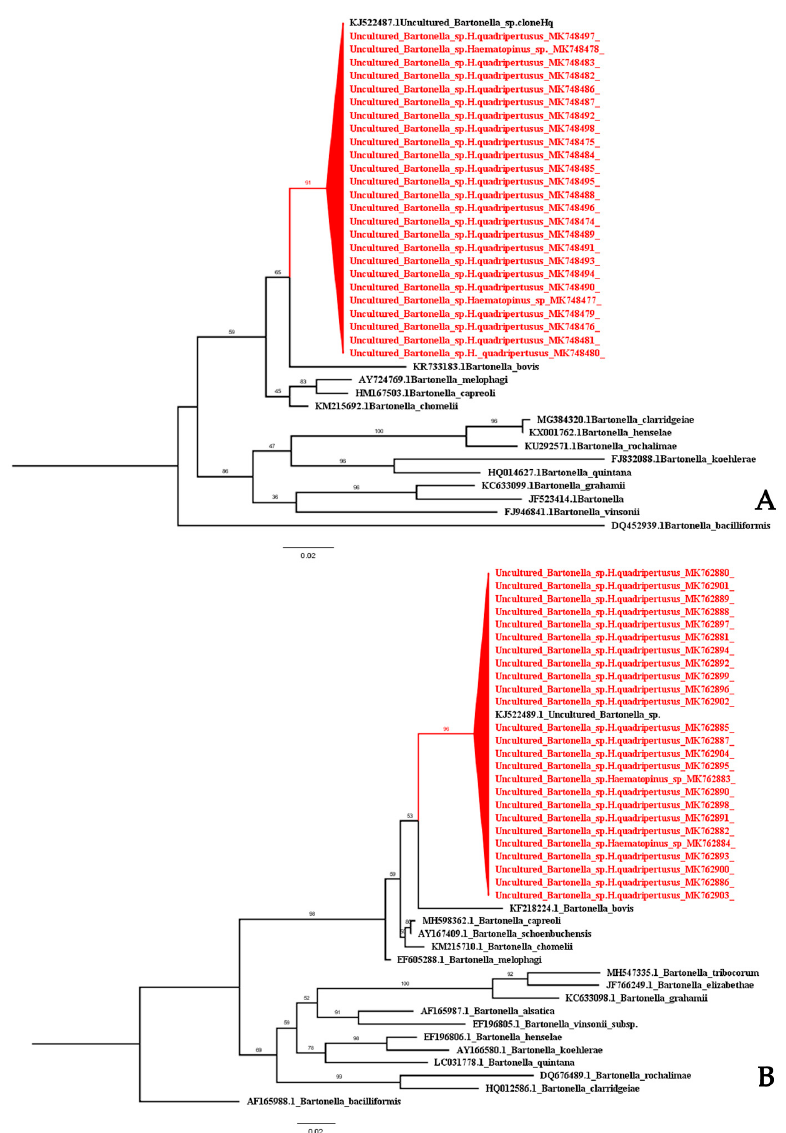
Figure 2. Phylogenetic tree of Bartonella spp. from cattle lice based on partial gltA ( A ) and rpoB ( B ) regions. The maximum likelihood was constructed with IQ-TREE by using the maximum-likelihood method with 1000 ultrafast bootstrap replicates. The best-fit model of substitution was found using the auto function on the IQ-TREE web server. The sequences from this study are indicated with a red color.